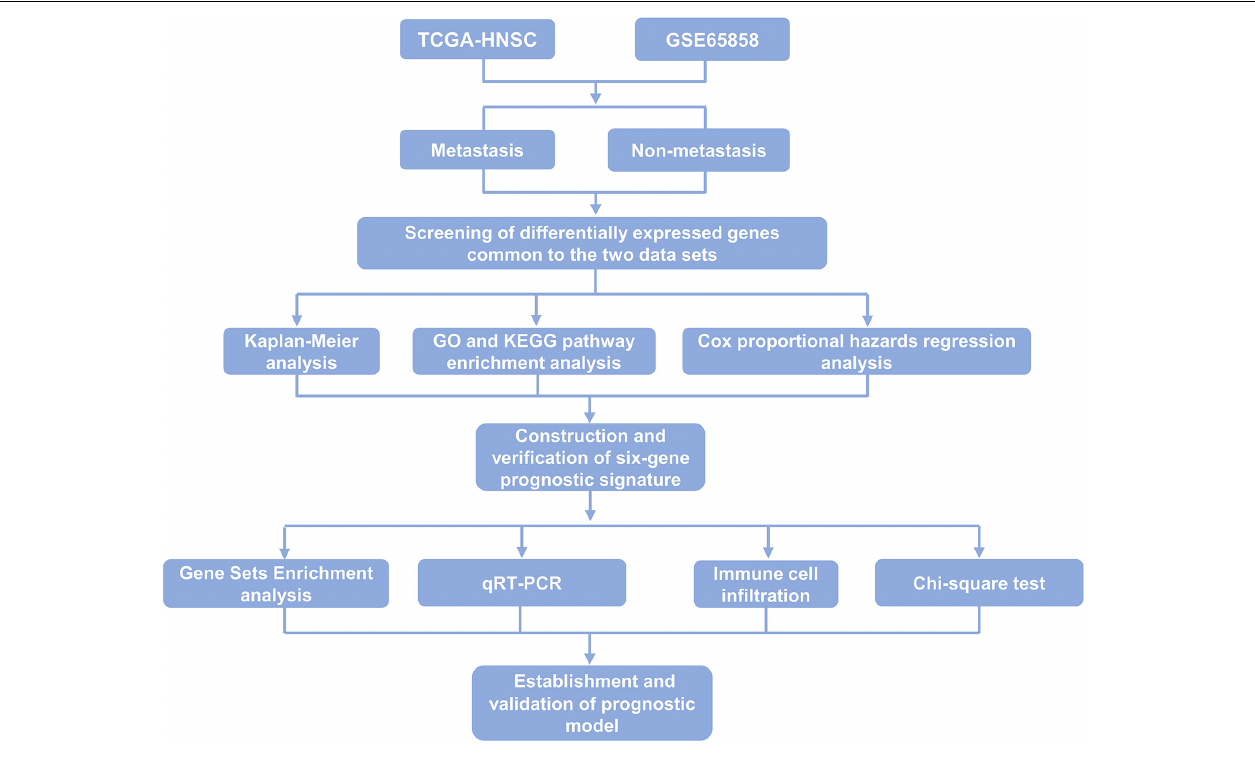
FIGURE 1 | Flow chart of the main procedures of this